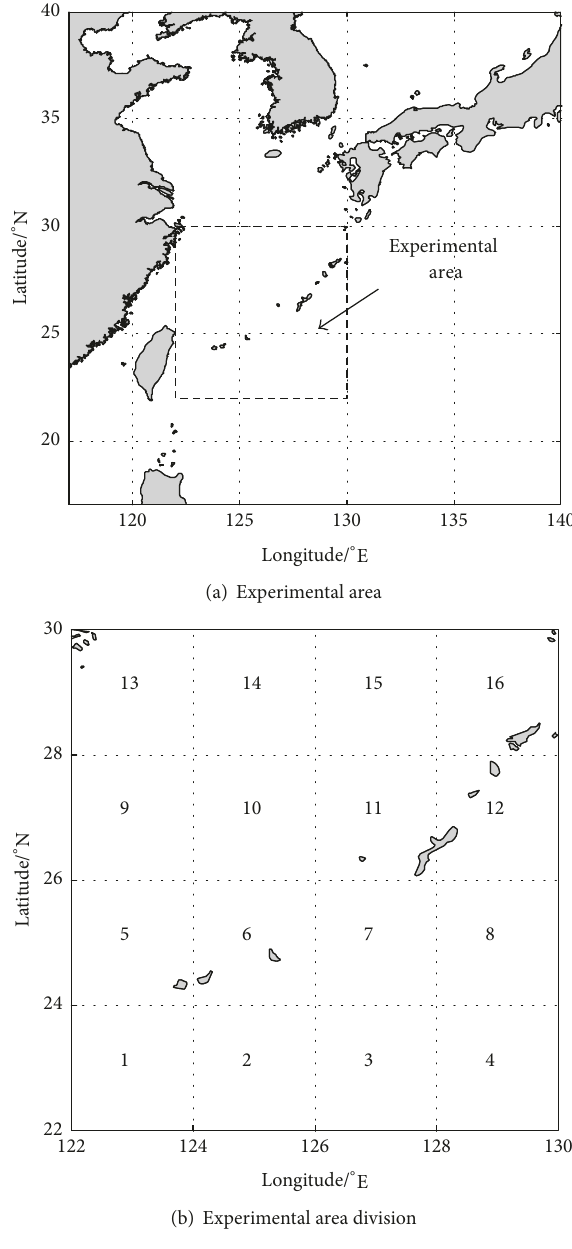
Figure 5: Experimental